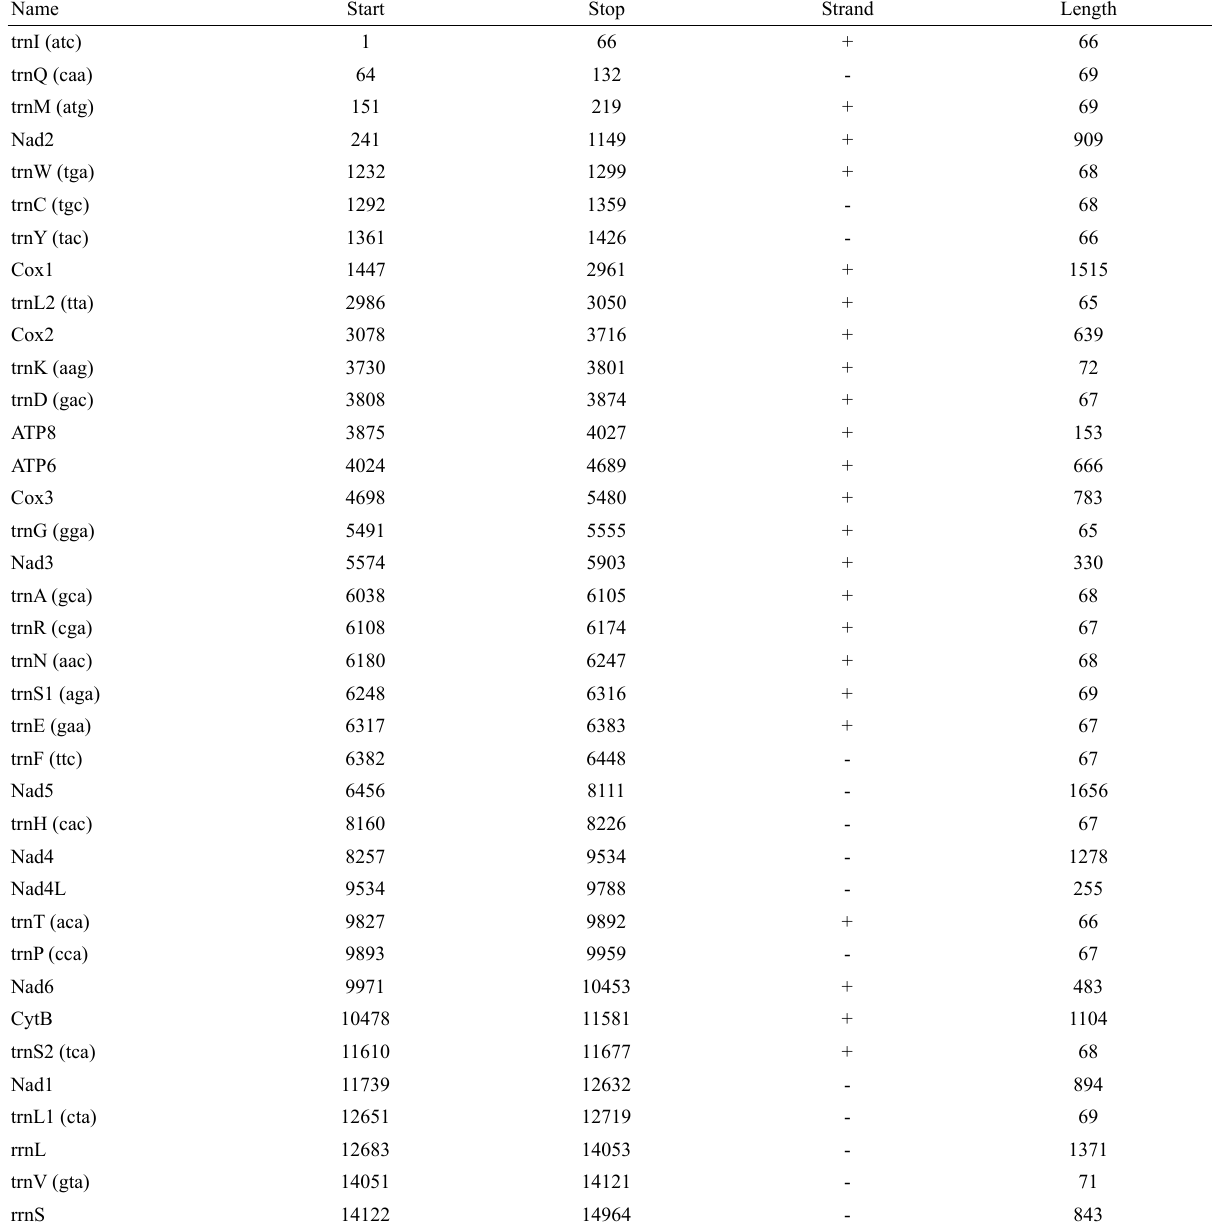
Table 1. Gene annotation in the mitogenome of Coprophanaeus ensifer